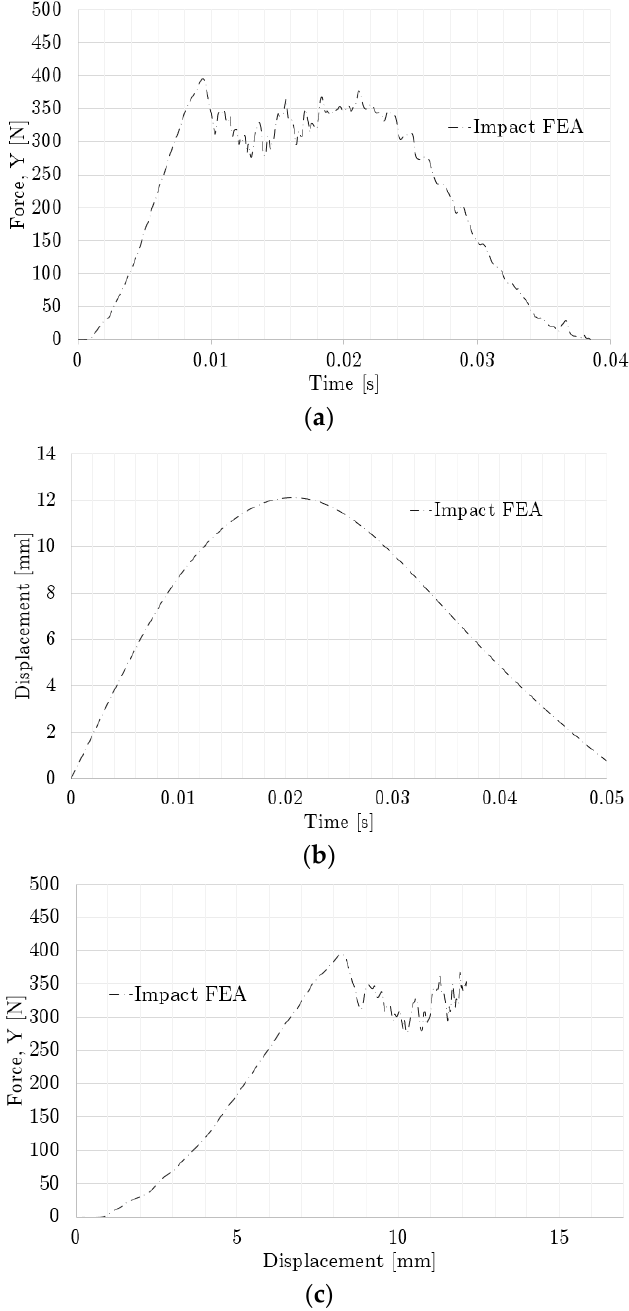
Figure 14. Impact loading for the inversed side-graded setup: ( a ) Force history, ( b ) Displacement history, and ( c ) Force–displacement curve.